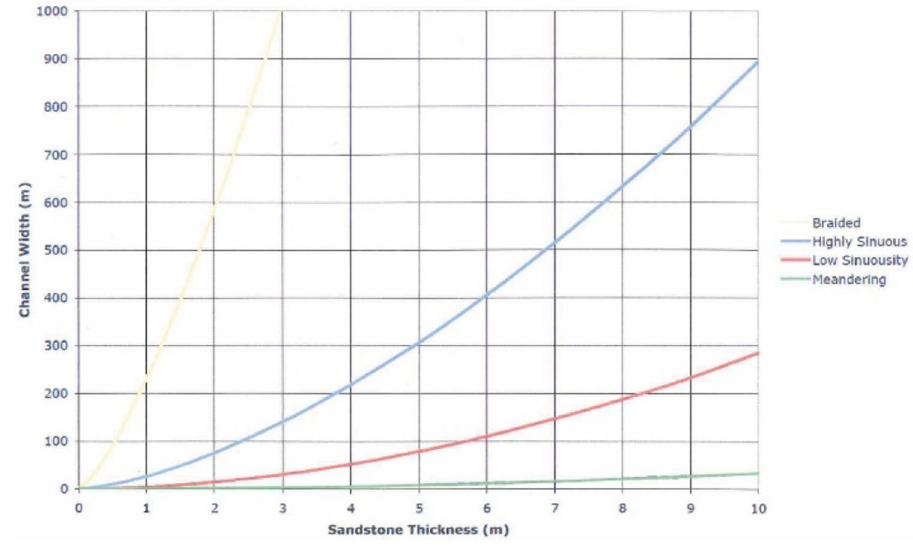
Fig. 3 Empirical relationship between thickness and width of channel (X-4X 2006)